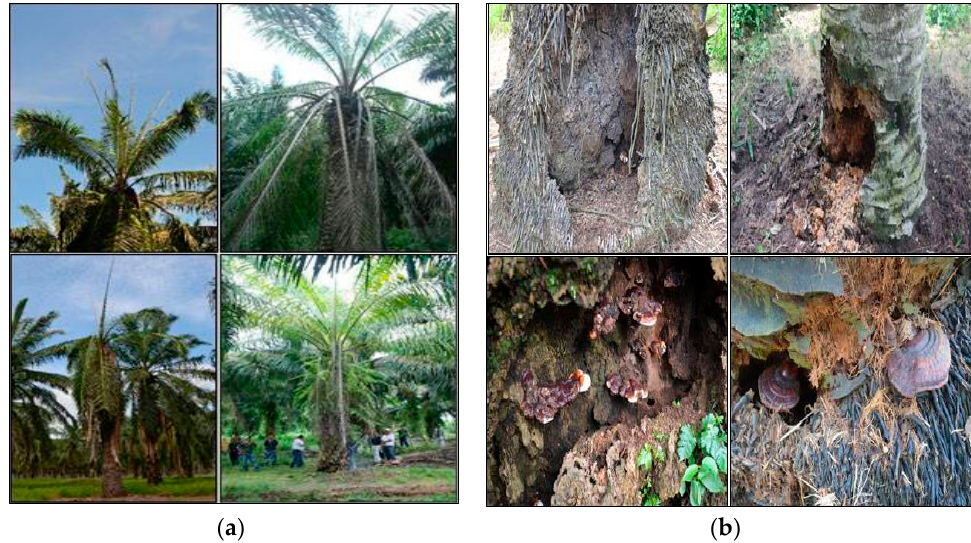
Figure 2. Some of the symptoms of oil palm trees affected by Ganoderma BSR disease. ( a ) Two or more unopened spear leaves, yellowing of leaves, and dried fronts; ( b ) stem and bole rotting at the base of the palm, and bracket-shaped form of Ganoderma pathogen at the stem and roots of the palm.